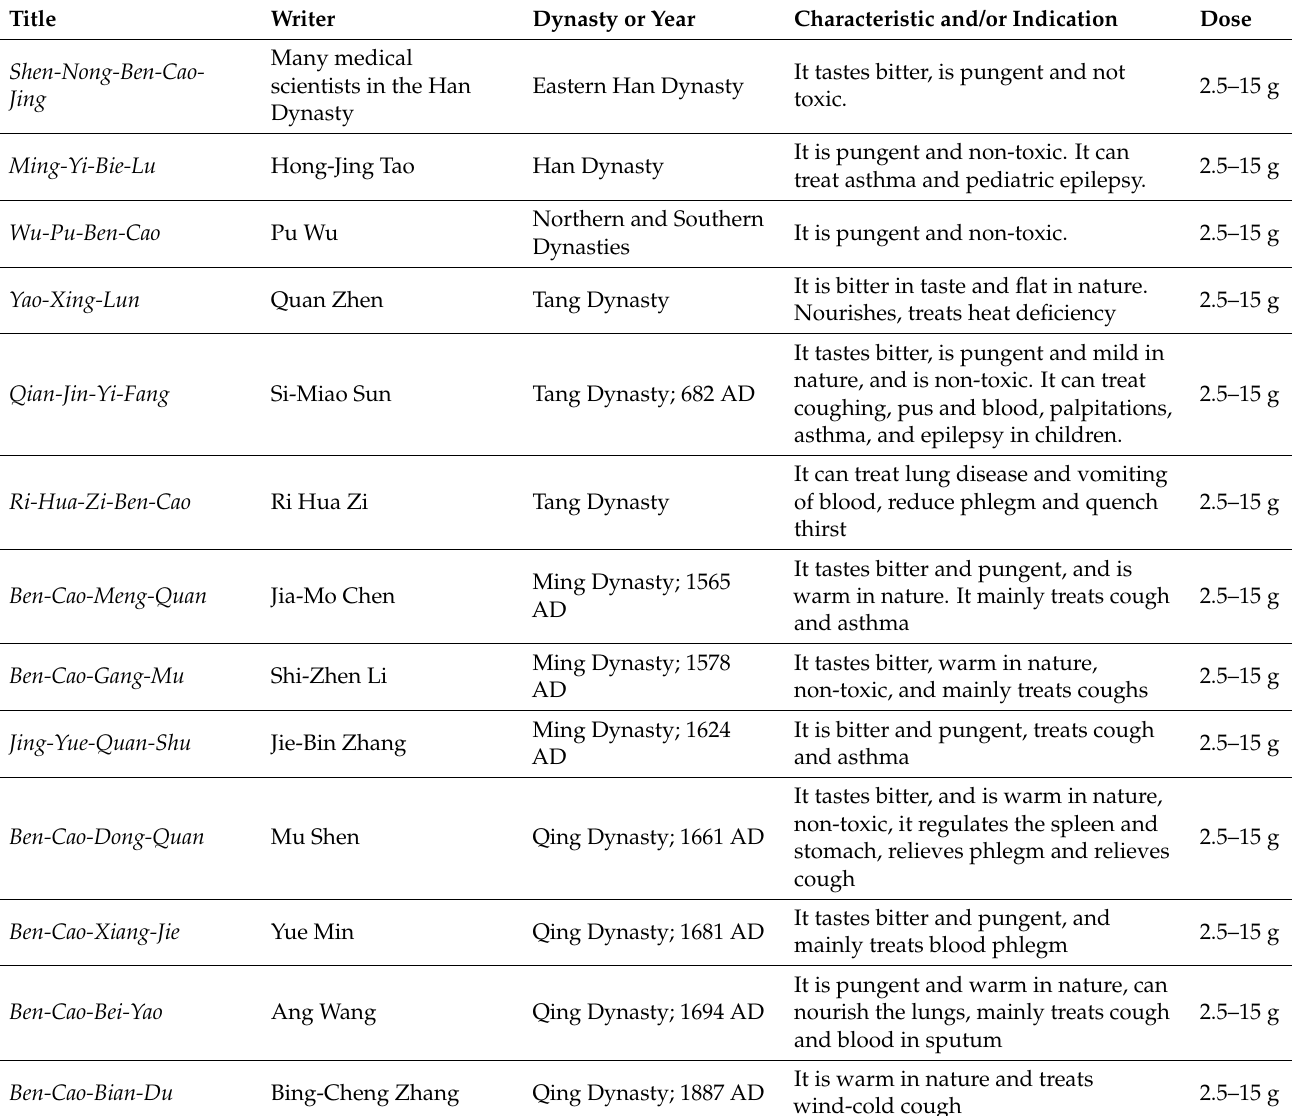
Table 1. Radix Asteris prescriptions throughout the Chinese